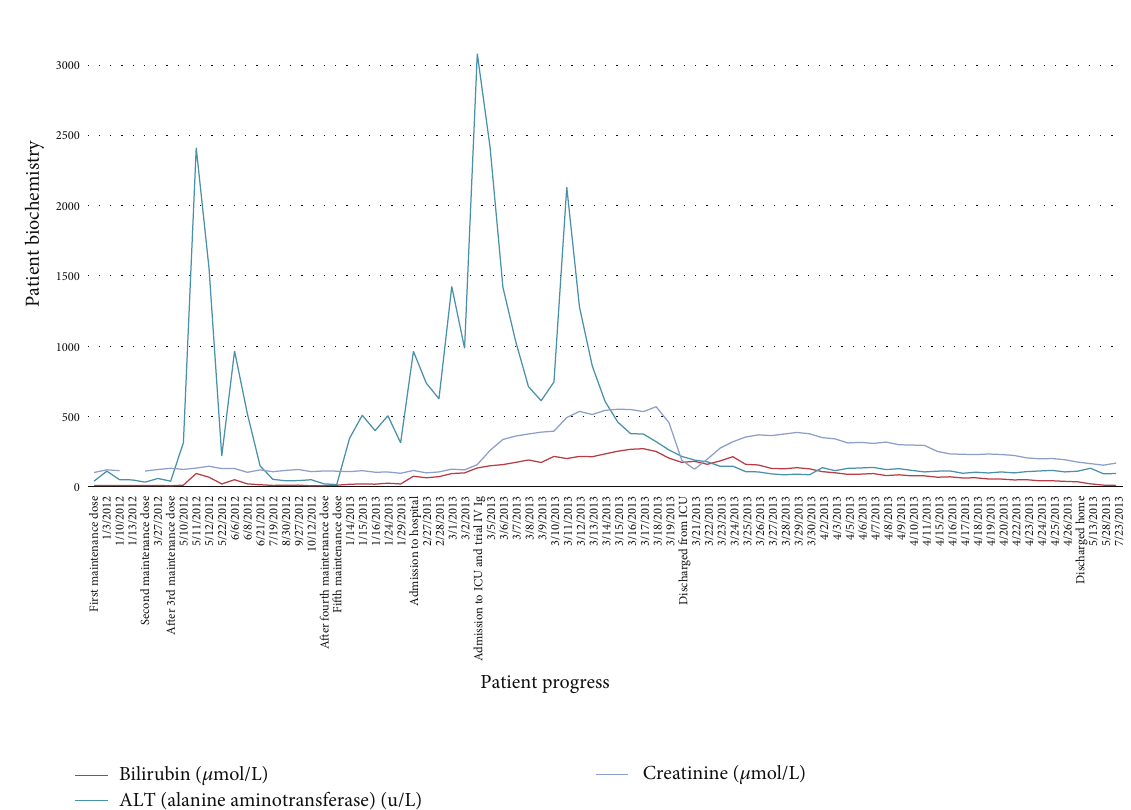
Figure 1: Summary of biochemistry findings: the graph shows the clinical events prior to and during the patient’s admission to hospital and the pattern observed in both liver and renal